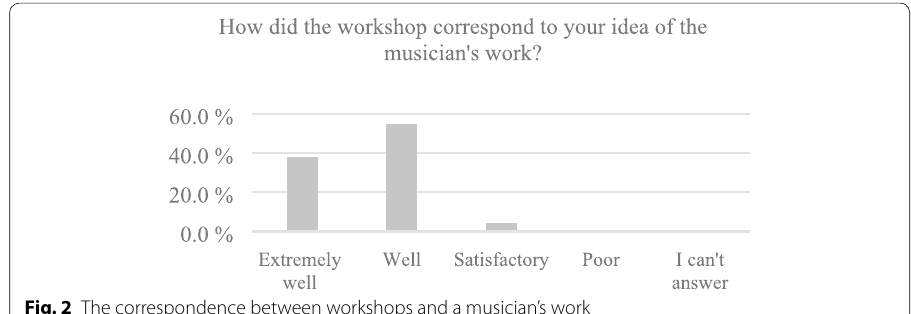
Fig. 2 The correspondence between workshops and a musician’s work